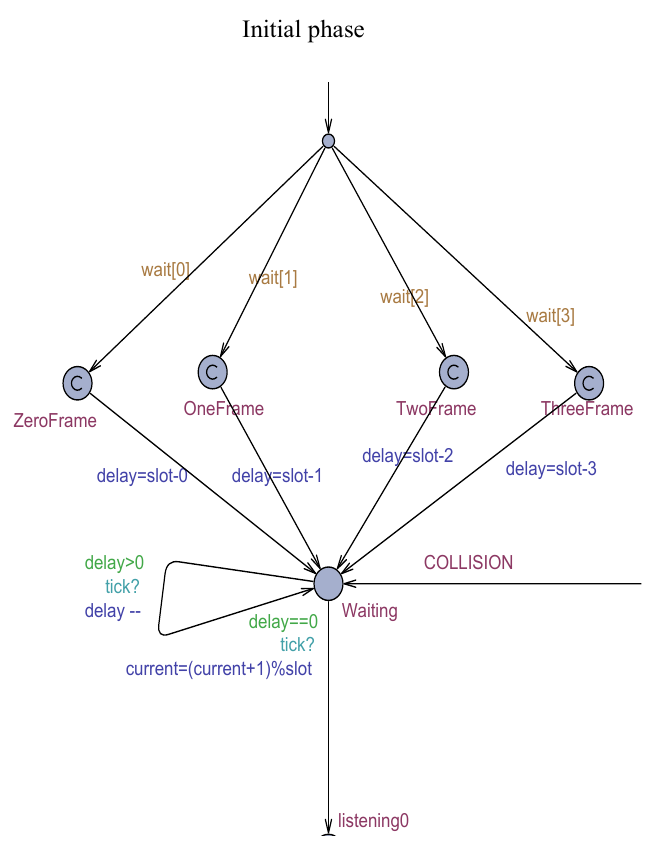
Figure 5. Probabilistic Wait